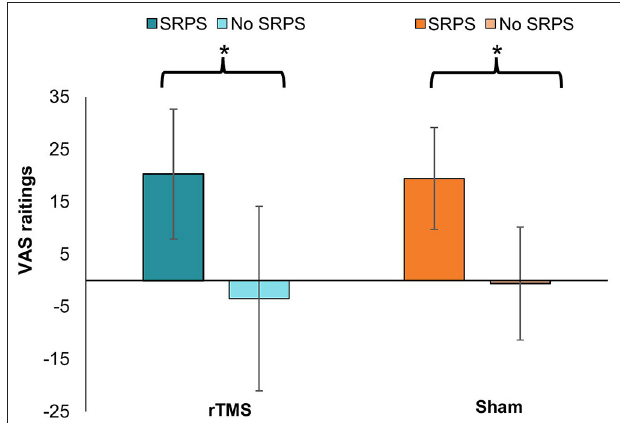
FIGURE 4 | Differences from baseline VAS pain ratings according to SRPS exposure during rTMS and sham visit. rTMS, repetitive transcranial magnetic stimulation; SRPS, surreptitious reduction of pain stimulus; VAS, visual analog scale. The * indicates the difference between the groups ( p ≤